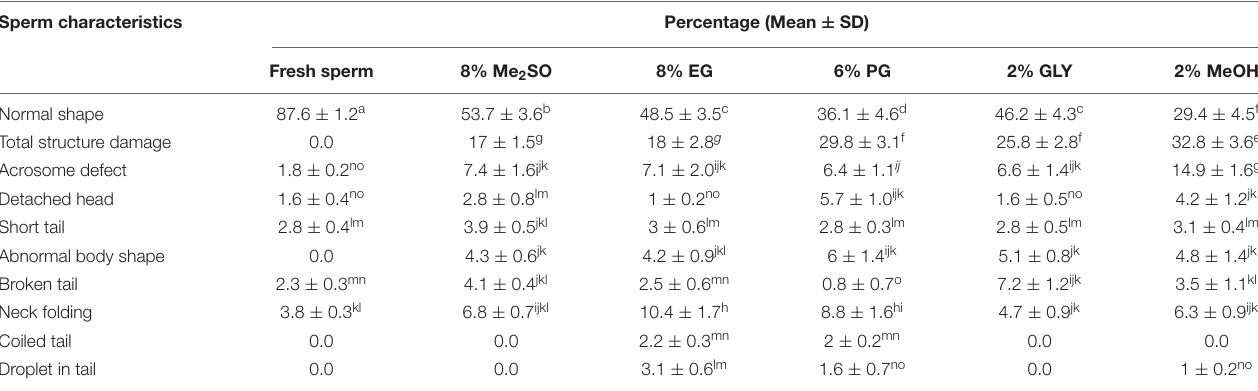
TABLE 4 | Cryo-defects of sperm cryopreserved with different types of cryoprotectants. Sperm